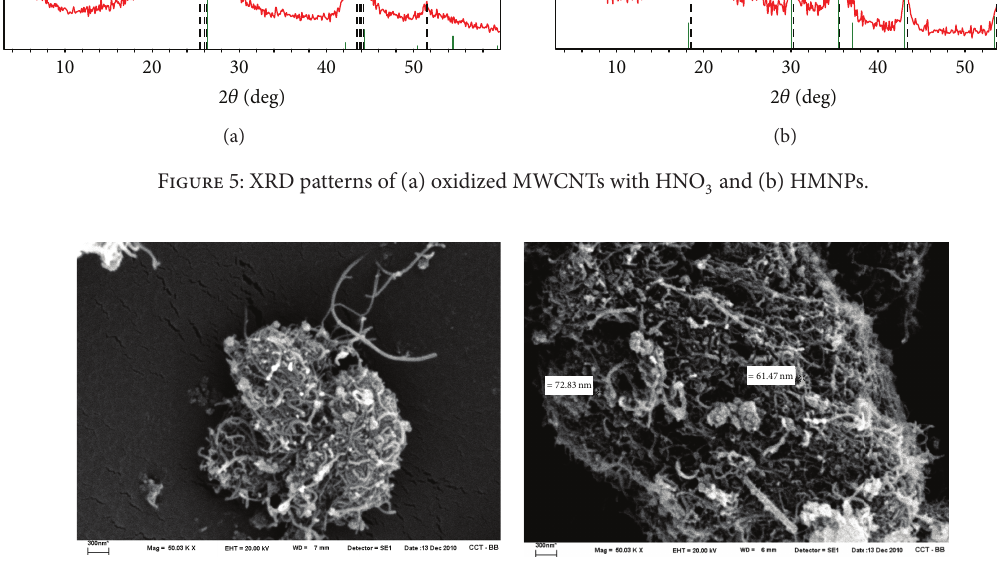
Figure 6: SEM images of HMNPs at 50000x. The scale in all figures is